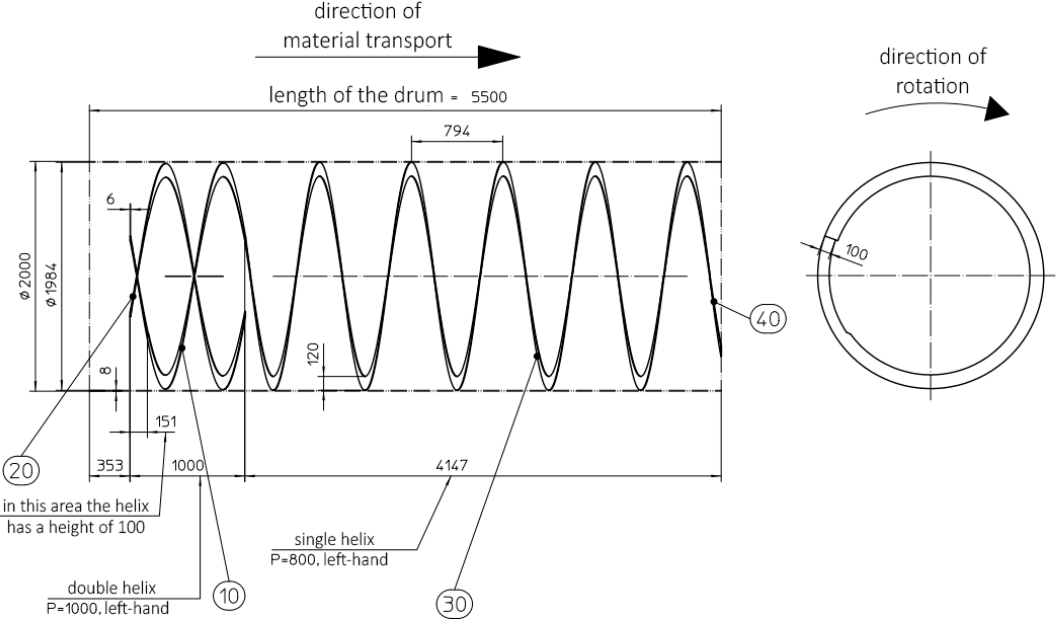
Figure A3. Screening drum geometry. Table A2. Data of the screening drums.